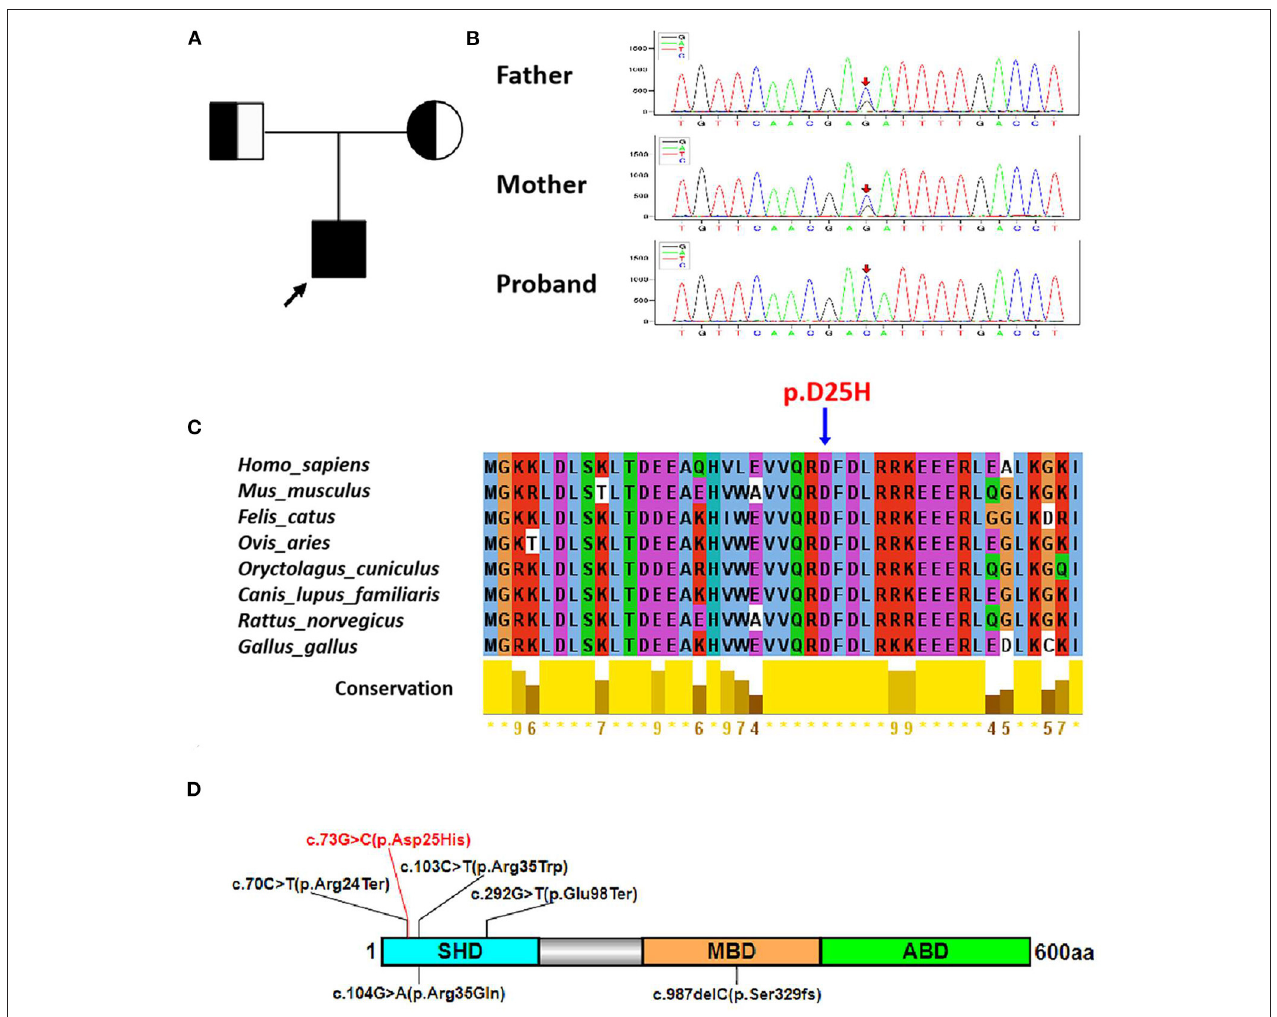
FIGURE 2 | The p.D25H variant in the patient with GS3. (A) A pedigree of the GS3 family. The black arrow indicates the proband. (B) Sanger sequencing analysis shows the homozygous c.73G > C mutation in proband, the heterozygous c.73G > C mutation in the parents of the patient. Red arrows show the mutational site. (C) Sequence alignment of MLPH protein in different species. The blue arrow indicates the mutational site. (D) Schematic representation of human MLPH protein structure. The novel missense mutation in this study and other reported mutations in MLPH are represented by red and black lines, respectively. SHD, Slp homology domain; MBD, MYO5A-binding domain; ABD, actin-binding